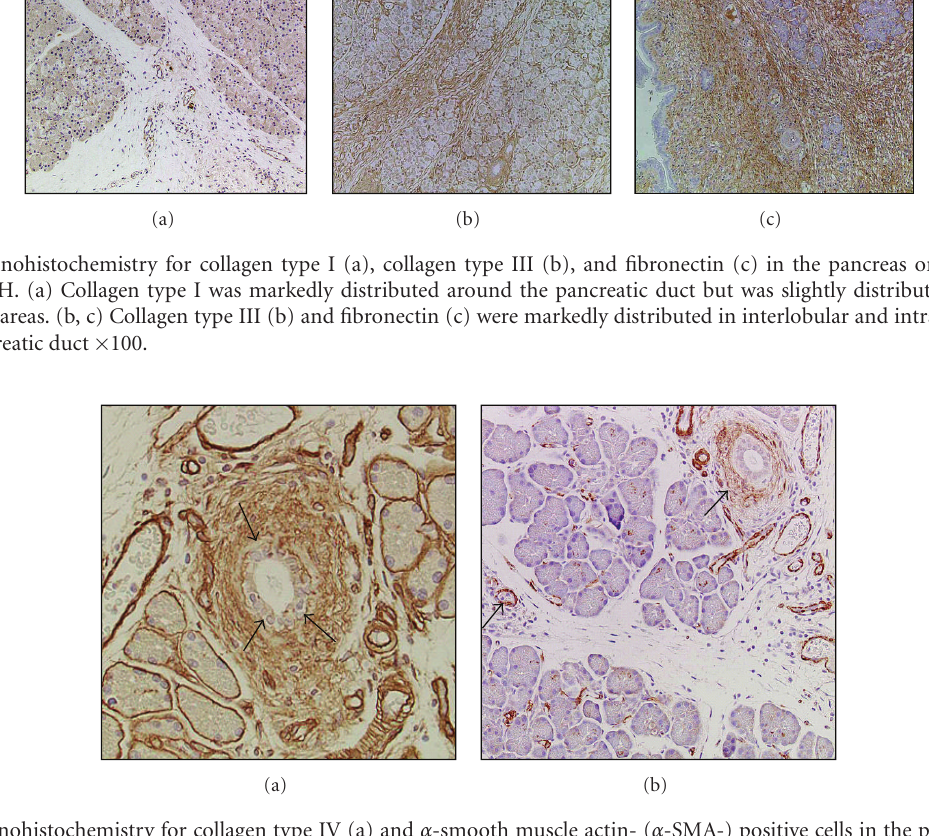
Figure 8: Immunohistochemistry for collagen type IV (a) and α -smooth muscle actin- ( α -SMA-) positive cells in the pancreas on day 14 after the induction of PDH. (a) Type IV collagen deposition was observed as irregular and discontinuous lines along the basement membrane of the ducts. In addition, broad deposition of type IV collagen was observed around the ducts. (b) α -SMA-positive cells were detected in the periductal, periacinar, and interstitial areas. Original magnification ×